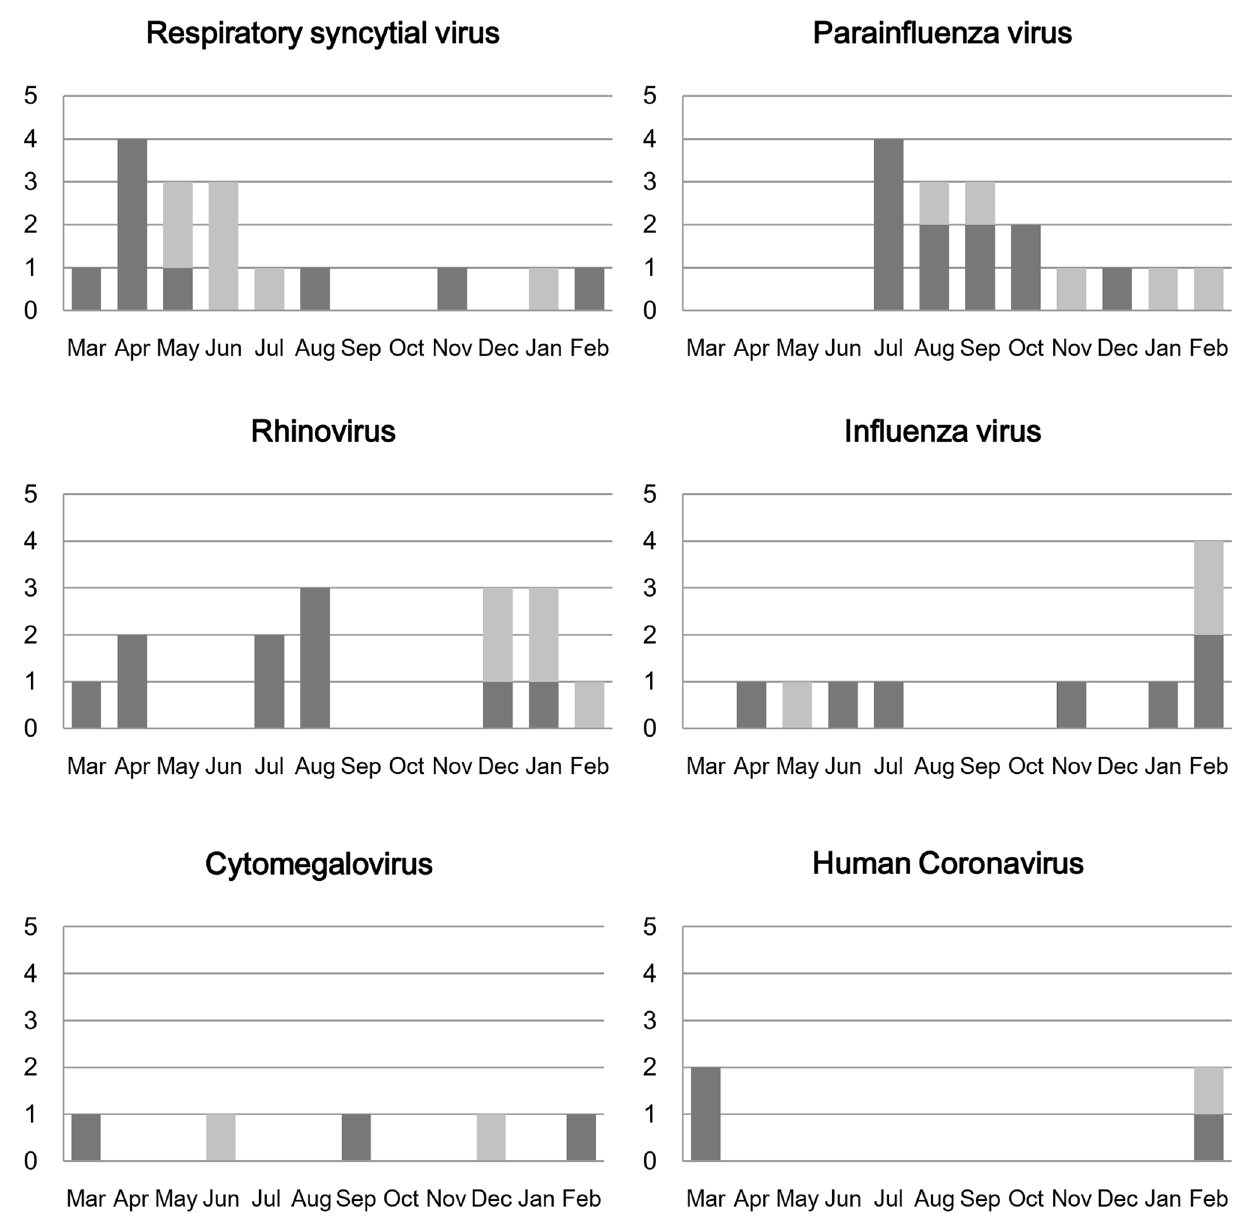
Figure 2. Monthly distribution of respiratory viruses detection. Black represents virus-positive cases in the first year and grey represents virus-positive cases in the second year.